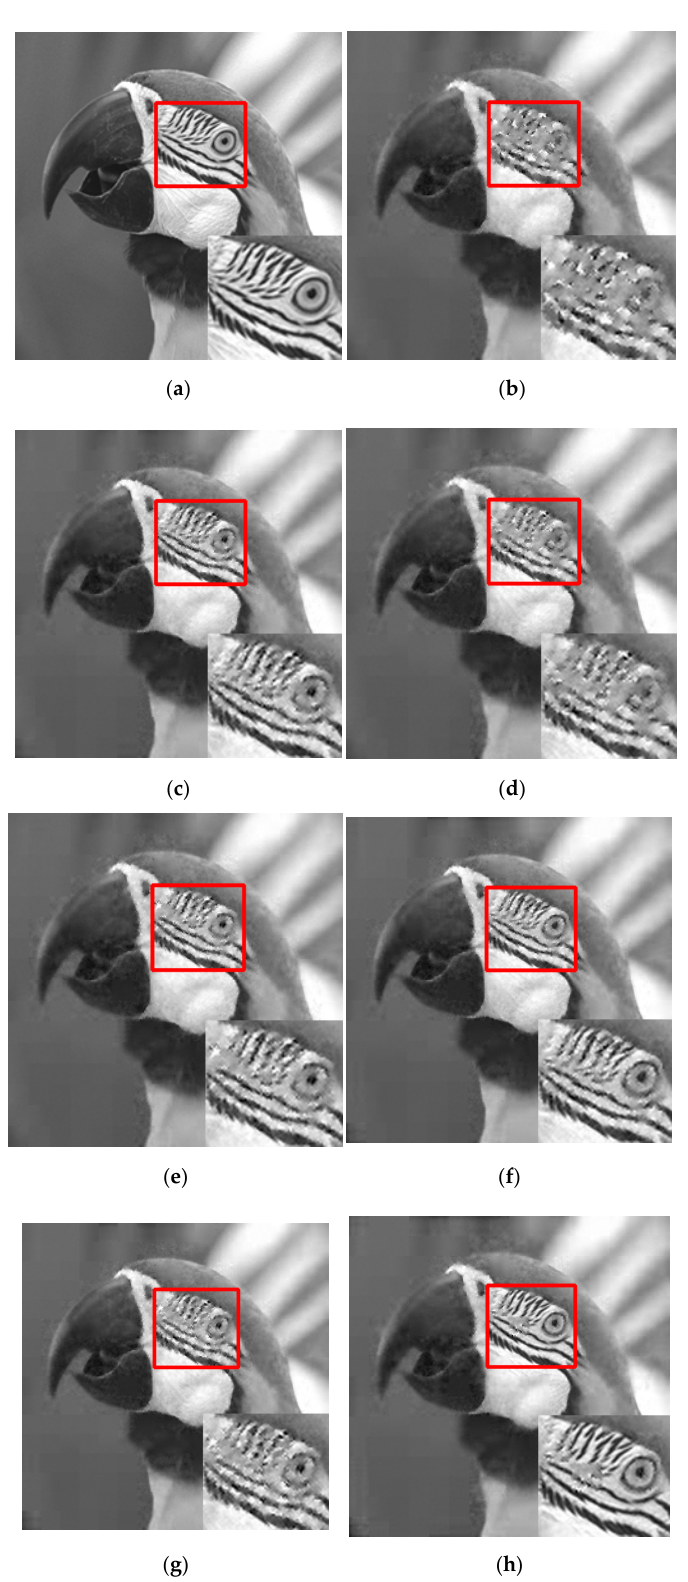
Figure 15. Visual comparisons of Parrot when using different ABCS schemes at sampling rate of 0.2: ( a ) original image; ( b ) Non-adaptive Scheme; ( c ) STD-based scheme; ( d ) MC-based scheme; ( e ) PCT-based scheme; ( f ) EFM-based scheme; ( g ) PFM-based scheme; ( h ) LFM-based scheme. In addition, we compare the performance of different ABCS schemes on the BSD68 dataset. Table 3 shows the average PSNR values of the BSD68 dataset for different ABCS schemes. Figure 16 shows the boxplots of PSNR gains of the BSD68 dataset for different ABCS schemes. Table 3. Average PSNR (dB) of BSD68 datasets for different ABCS schemes. Sampling Scheme